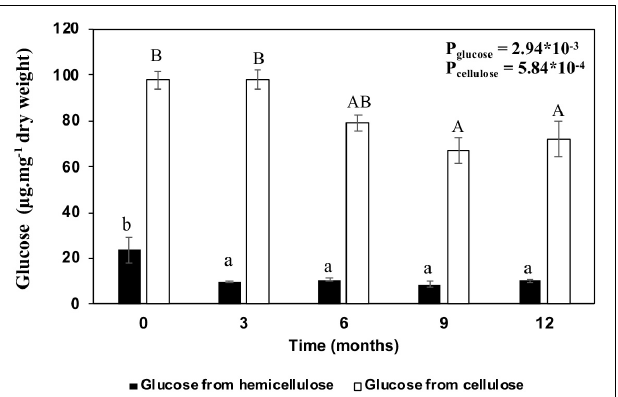
FIGURE 5 | Comparison between glucose degradation from hemicellulose and cellulose of sugarcane straw in the field. Bars represent the average ± standard error. Dark bars represent the glucose from hemicellulose and light bars glucose from cellulose. Different letters are significant differences by Tukey’s test ( P < 0.05; n = 5).